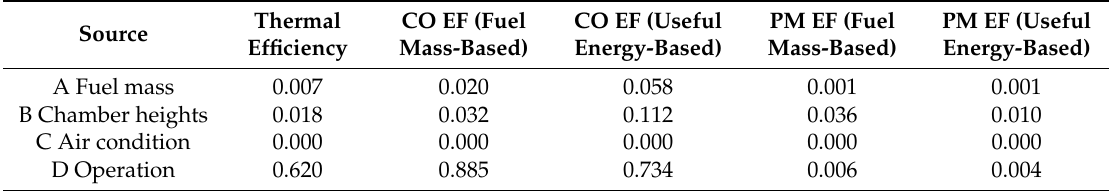
Table 4. Significant influences of different